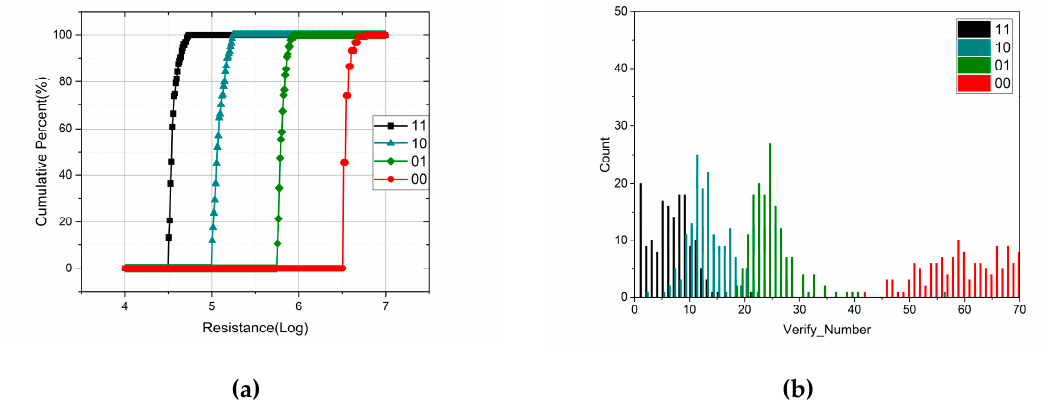
Figure 11. ( a ) Resistance distribution of four states in phase change memory (PCM) cells with the write and verify scheme; ( b ) the number of iterations.